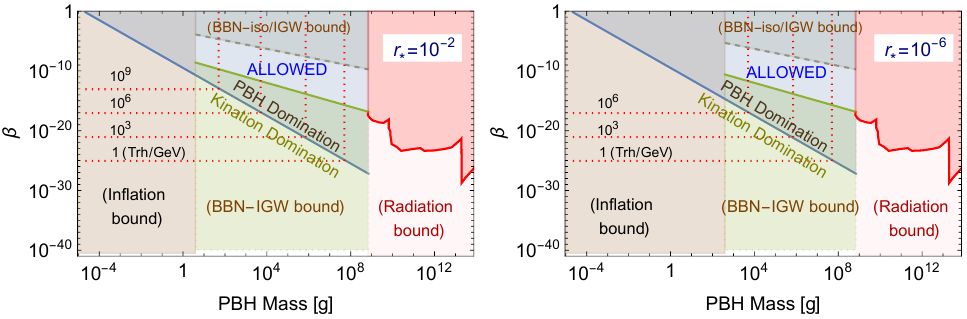
Figure 6. In this figure we depict the combined constraints for the scenario of an early kination domination phase reheated via PBH evaporation. The allowed parameter space ( M PBH , β ), that gives viable cosmology, lies in the PBH domination region. The left part of the parameter space (gray area) is excluded by the energy scale of inflation that determines the minimum PBH mass, shown for two different r ∗ values. The right part of the parameter space is excluded by the requirement of radiation domination during BBN (red area). The induced GW constraints due to BBN/CMB exclude a great part (green area) of the parameter space as described in the text. The red dotted lines indicate the reheating